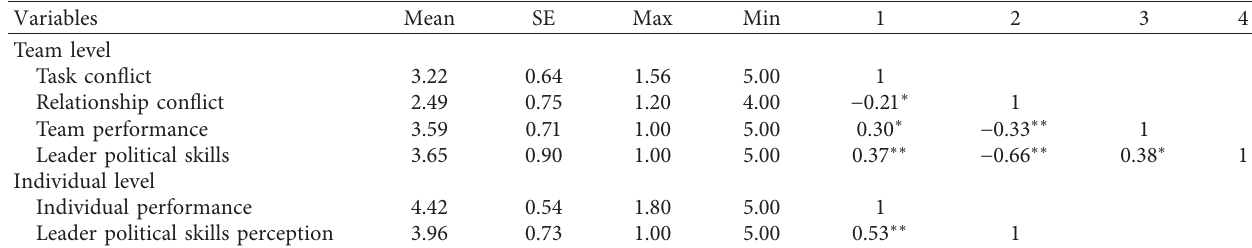
Table 1: Means, standard deviations, and